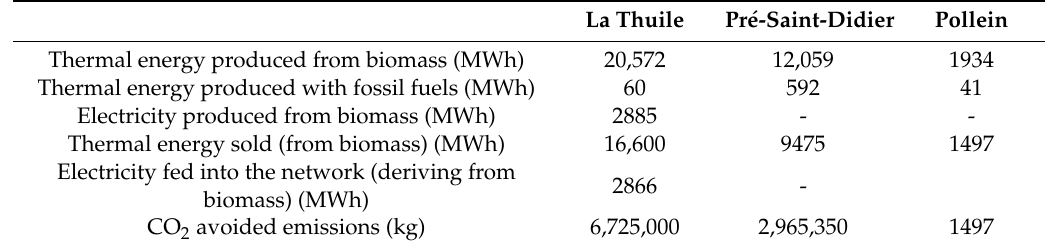
Table 5. Total energy produced during 2015 in La Thuille, Pr é -Saint-Didier and Pollein [107]. La Thuile Pr é -Saint-Didier Pollein Thermal energy produced from biomass (MWh) 20,572 12,059 1934 Thermal energy produced with fossil fuels (MWh) 60 592 41 Electricity produced from biomass (MWh) 2885 - - Thermal energy sold (from biomass) (MWh) 16,600 9475 1497 Electricity fed into the network (deriving from 2866 - biomass) (MWh) 6,725,000 2,965,350